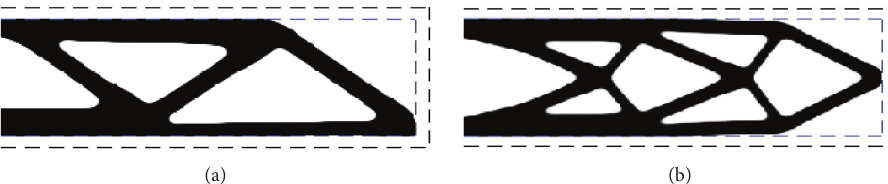
Figure 3: Beam FE structure domain dimension 3 × 1. (a) Final compliance f � 194, iterations � 550. (b) Final compliance f � 187, iterations � 400.